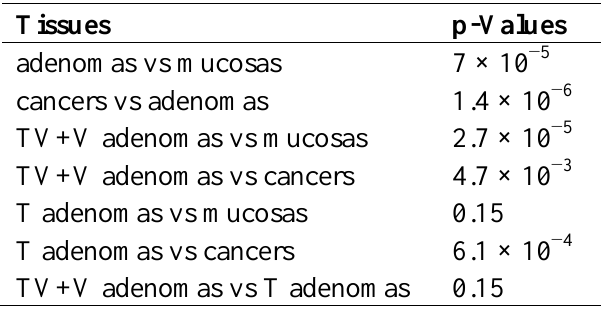
Table 2. (b) Enrichment test of hypomethylated